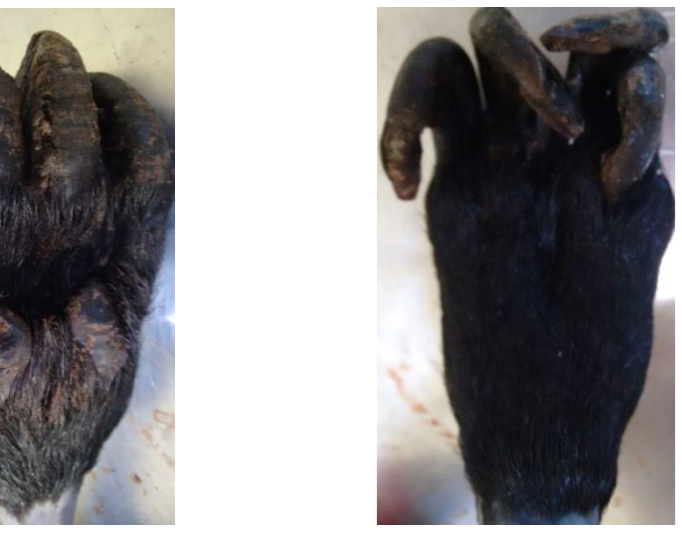
Figure 2. Palmar view of the accessory limb. Figure 3. Dorsal view of the accessory